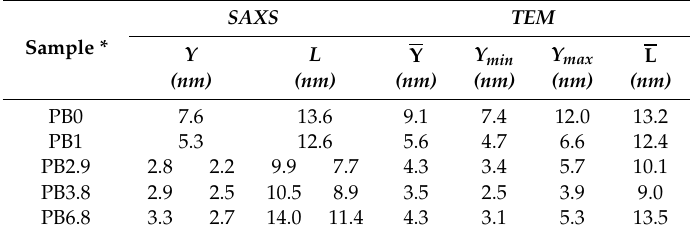
Table 5. Comparison of morphological parameters obtained by SAXS and TEM analysis